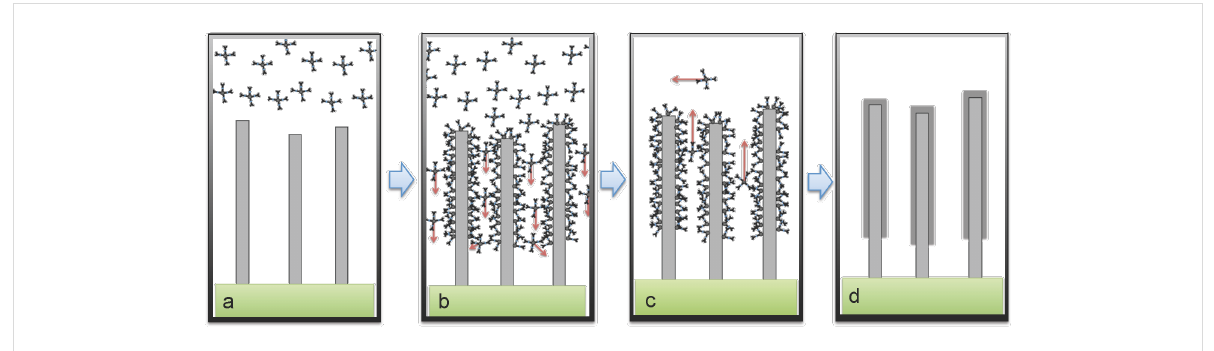
Figure 1: Illustration of one ALD cycle on a VACNT array. Upon exposure to the precursor gas (a: bulk gas diffusion), precursor molecules diffuse into the CNT array and adsorb onto available sites (b: confined diffusion and adsorption). After the defined precursor exposure time, purging of the ALD chamber removes unreacted precursor molecules from the chamber (c). After the oxidization pulse, a thin layer of oxide is formed on the surface